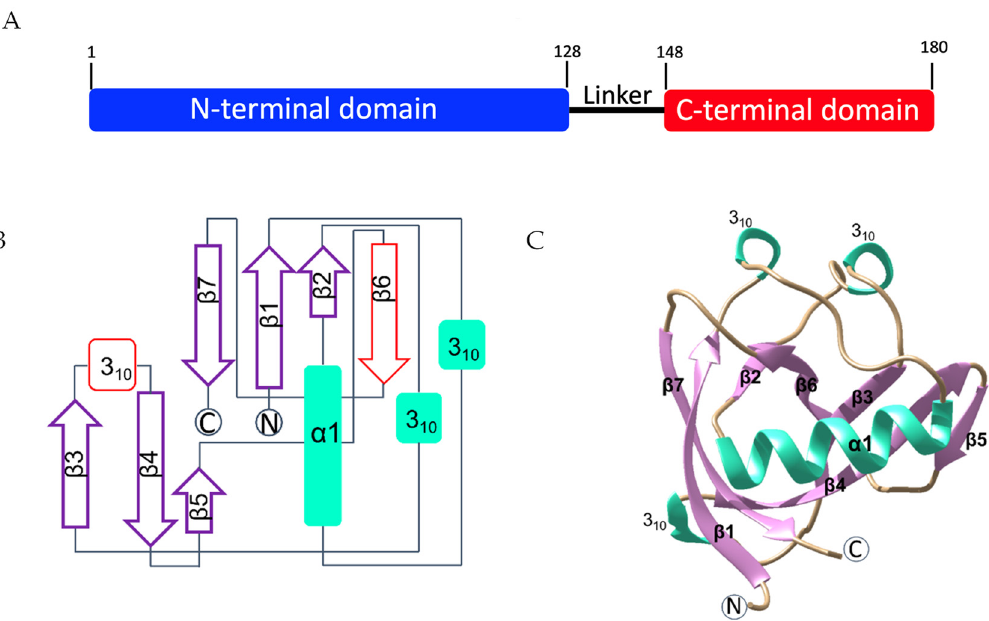
Figure 1. The structure of SARS-CoV-2 nsp1 10-126 . ( A ) Bar diagram of the nsp1 domain arrangement, including the N-terminal domain (blue), the flexible linker region (black) and the C-terminal domain (red). ( B ) Topological arrangement of SARS-CoV-2 nsp1 10-126 at high resolution, where newly identified structural features are coloured in red. ( C ) Cartoon representation of the structure. The secondary structure elements are depicted in different colours in the right panel with α -helixes coloured in green, β -strands shaded in purple, and loops are shown in tan. Table 1. Data collection, structure determination and refinement statistics for SARS-CoV-2 nsp1 10- 126 . Data in parenthesis correspond to the highest resolution shell.